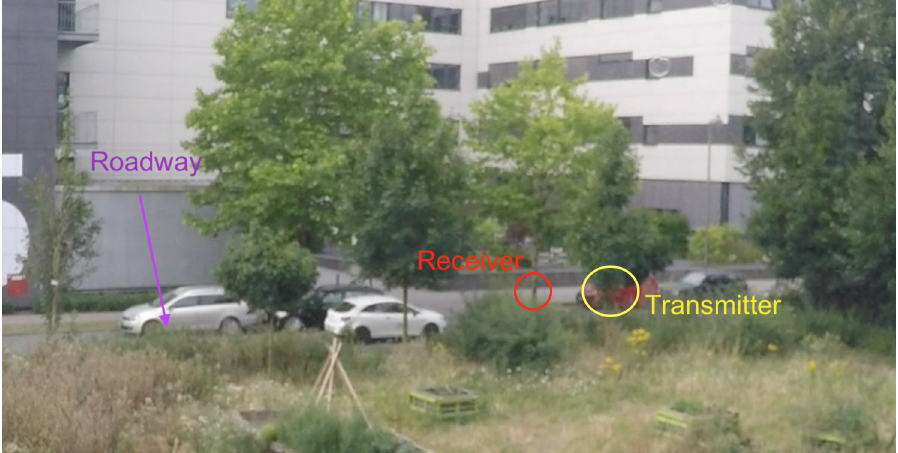
Figure 2. Experimental setup: Scenario 1 (Low traffic road: Heisenbergstraße).